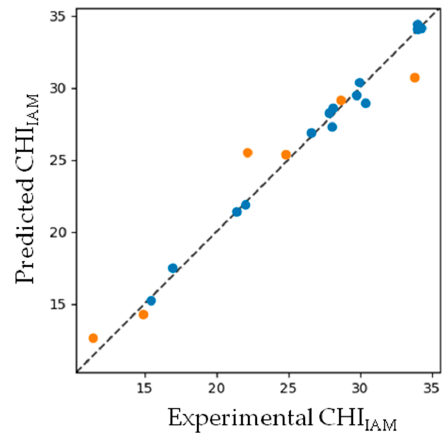
Figure 2. CHI IAM predictive ability plot of the DE-PLS model.